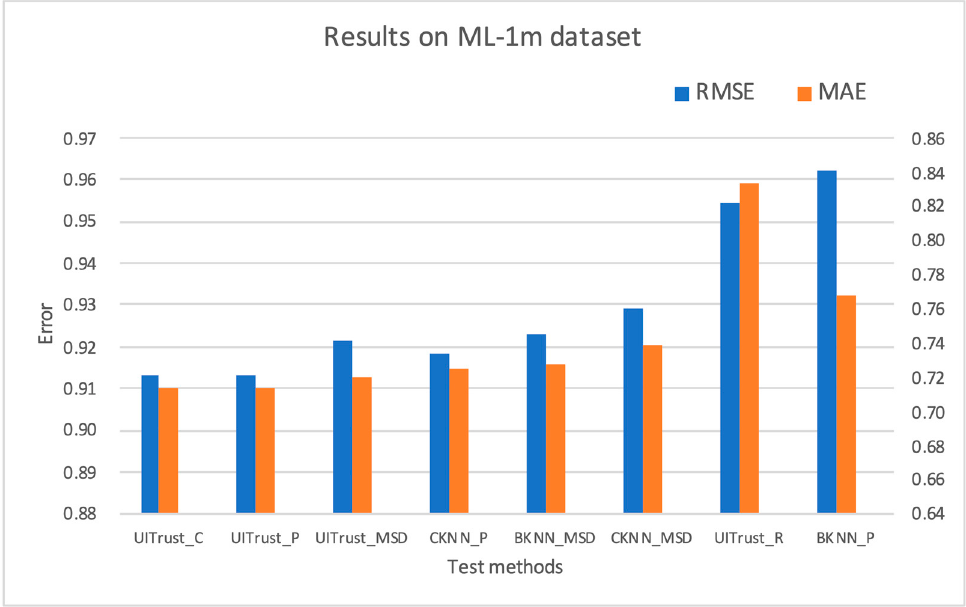
Figure 4. Prediction accuracy obtained using different methods for the ML-1m dataset. MAE—mean absolute error, RMSE—root mean square error.